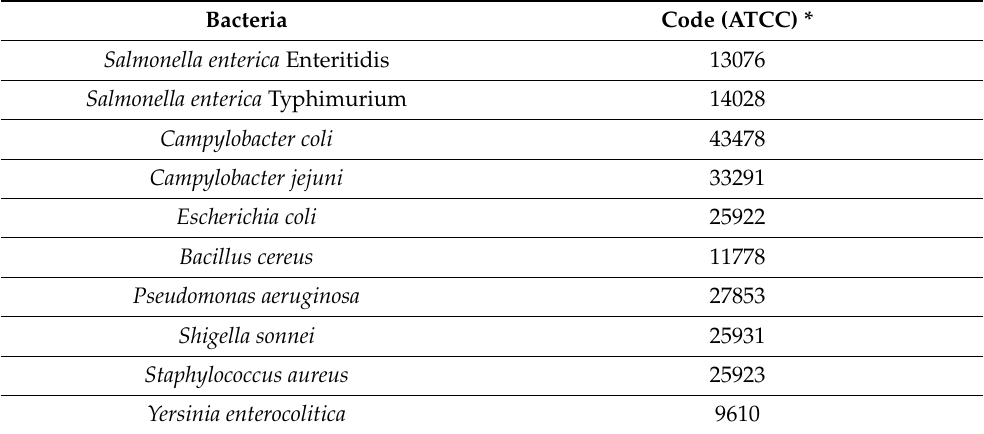
Table 1. List of bacteria selected for the analyses of specificity and exclusiveness.